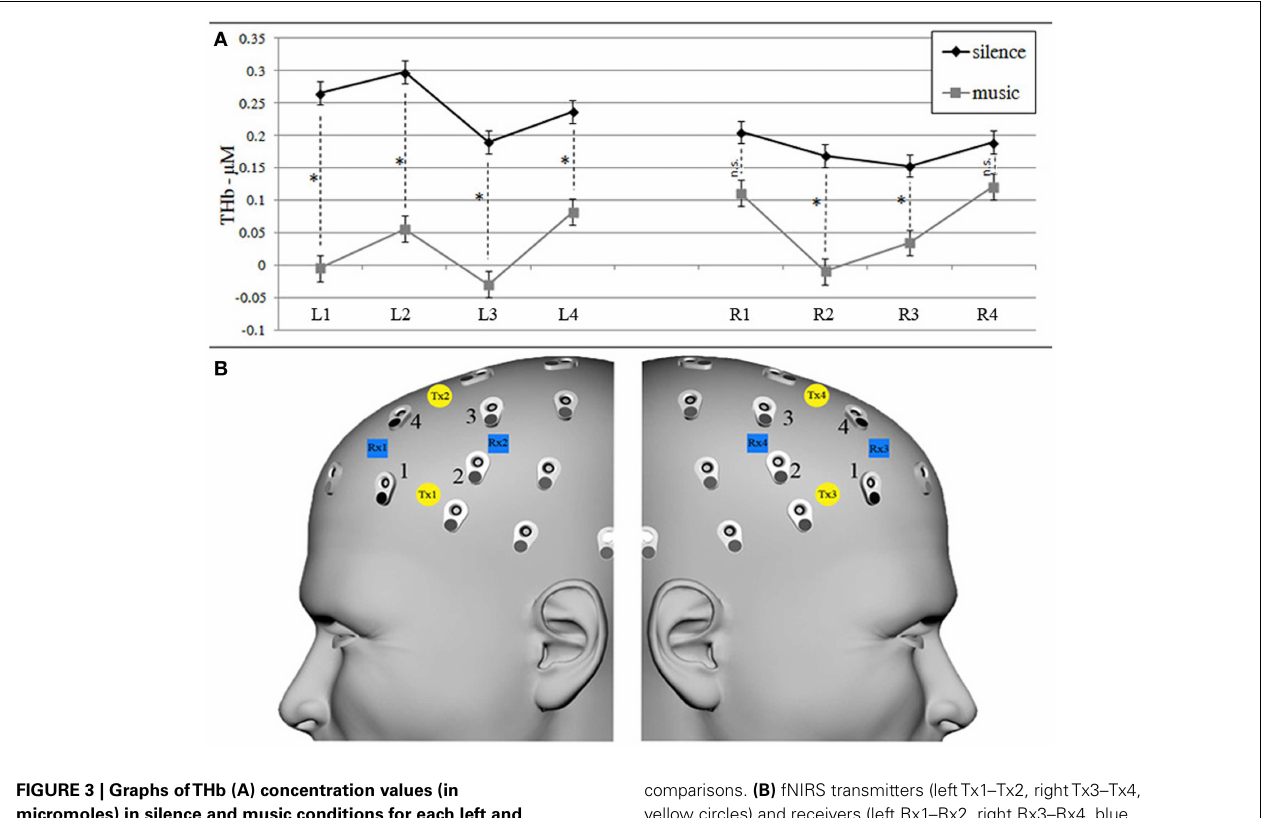
FIGURE 3 | Graphs ofTHb (A) concentration values (in micromoles) in silence and music conditions for each left and right fNIRS measurement channel (B) . (A) Mean ( ± SEM) ofTHb (O 2 Hb + HHb) concentration values for silence (black line) and music (gray lines) conditions. * Shows significant ( p < 0.05) within-channel differences obtained by post hoc Bonferroni-corrected paired t -test